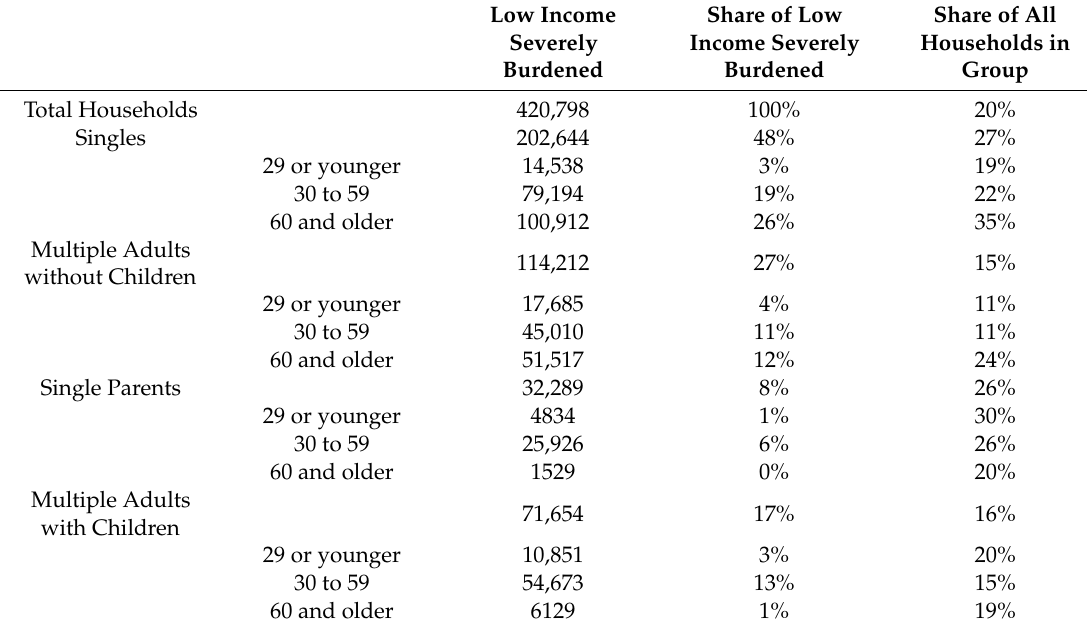
Table 1. Renter households by rent-burden type and household characteristics, New York City (2017)